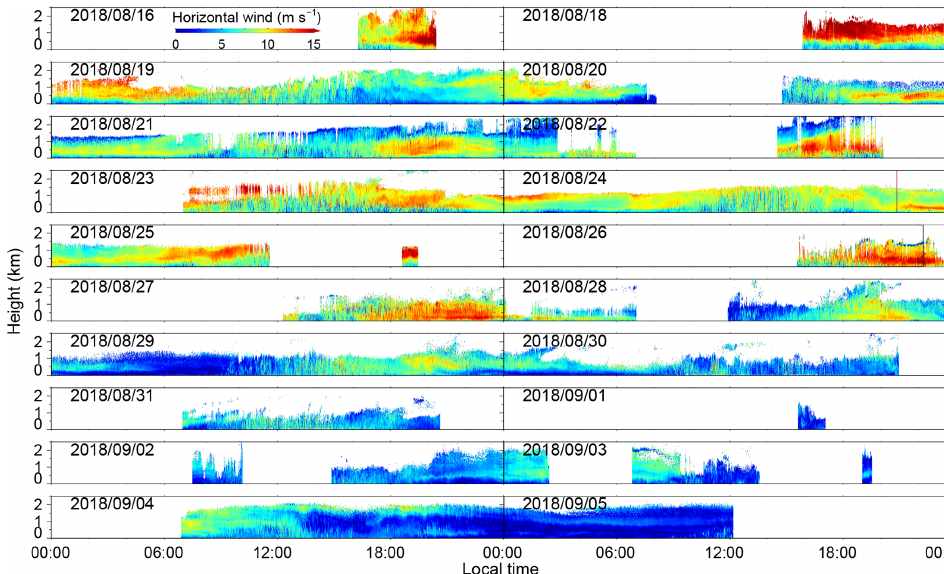
Figure A2. Similar to Fig. A1 but for horizontal wind